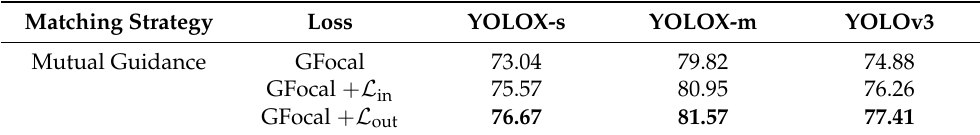
Table 3. Performance of YOLOX backbones on VEDAI25 when training with mutual guidance (MG) and contrastive loss.